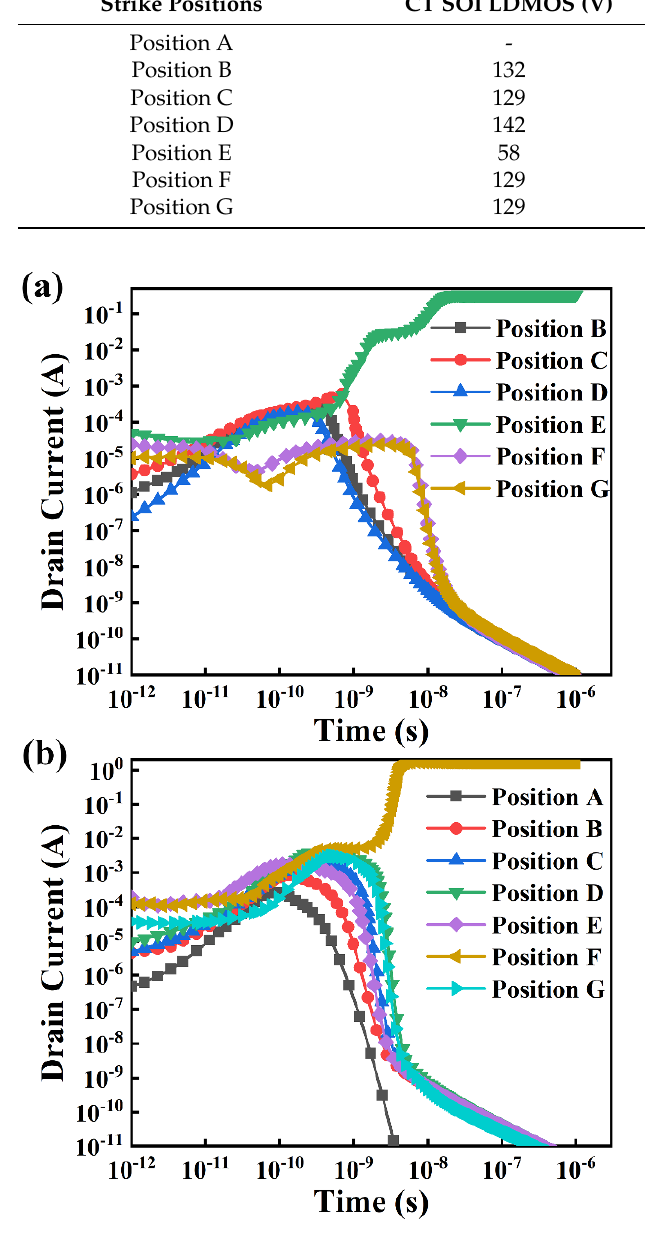
Figure 6. Drain current versus time after heavy ions with LET of 1 pC/ µ m strike at different positions of ( a ) the CT SOI LDMOS at V DS = 58 V and ( b ) the SJT SOI LDMOS at V DS = 173 V.